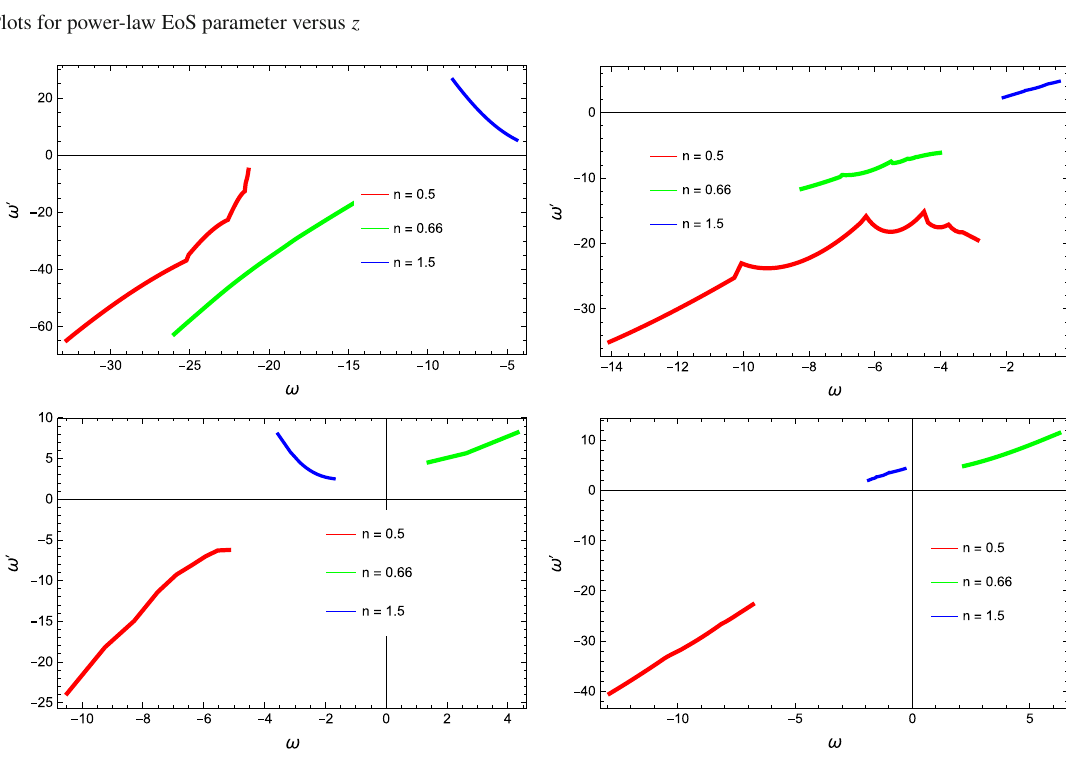
Fig. 4 Plots for power-law ω – ω (cid:2) versus